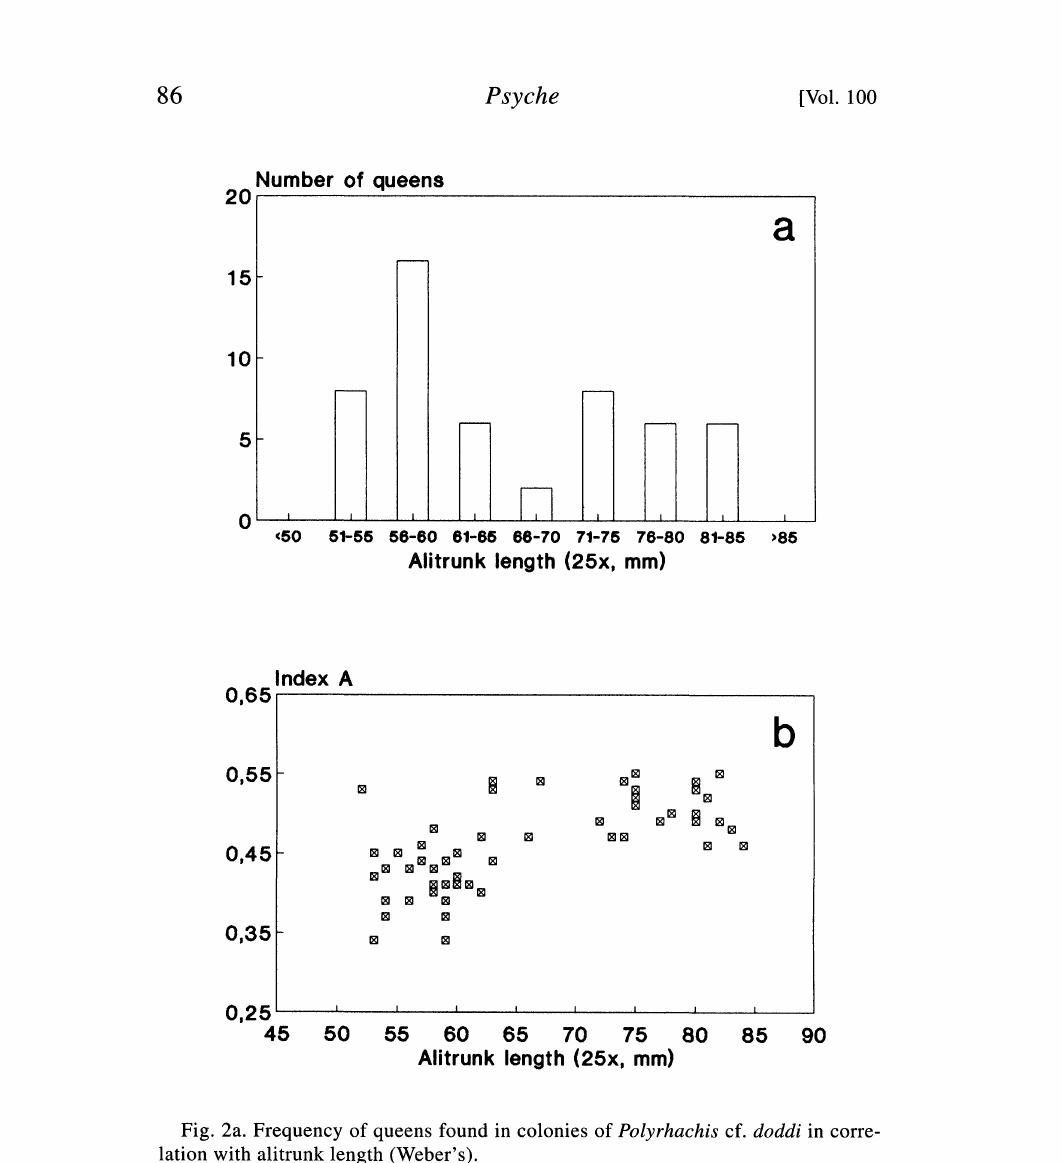
Fig. 2a. Frequency of queens found in colonies of Polyrhachis cf. doddi in corre- lation with alitrunk length (Weber’s). Fig. 2b. Variation of index A (the ratio of scutum length and alitrunk length, Tin- aut and Ruano 1992) in correlation to alitrunk length in queens of Polyrhachis cf.